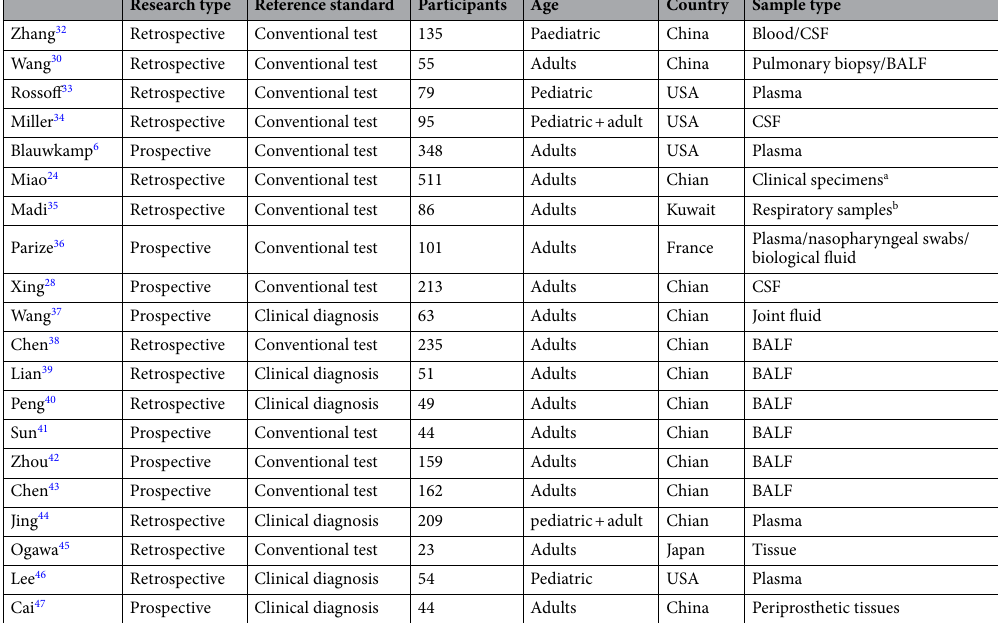
Table 1. Characteristics of Included Studies. a: Specimens included bronchoalveolar lavage fluid (BALF), cerebrospinal fluid (CSF), sputum, pleural fluid, tissue, pus, blood, ascetic fluid, bile, secretion, urine, herpes fluid, bone marrow, throat swab, pericardial fluid and saliva; b: The respiratory samples included nasopharyngeal aspirates/wash, nasopharyngeal swab, BALF, tracheal aspirates, sputum, throat swabs, and nasal